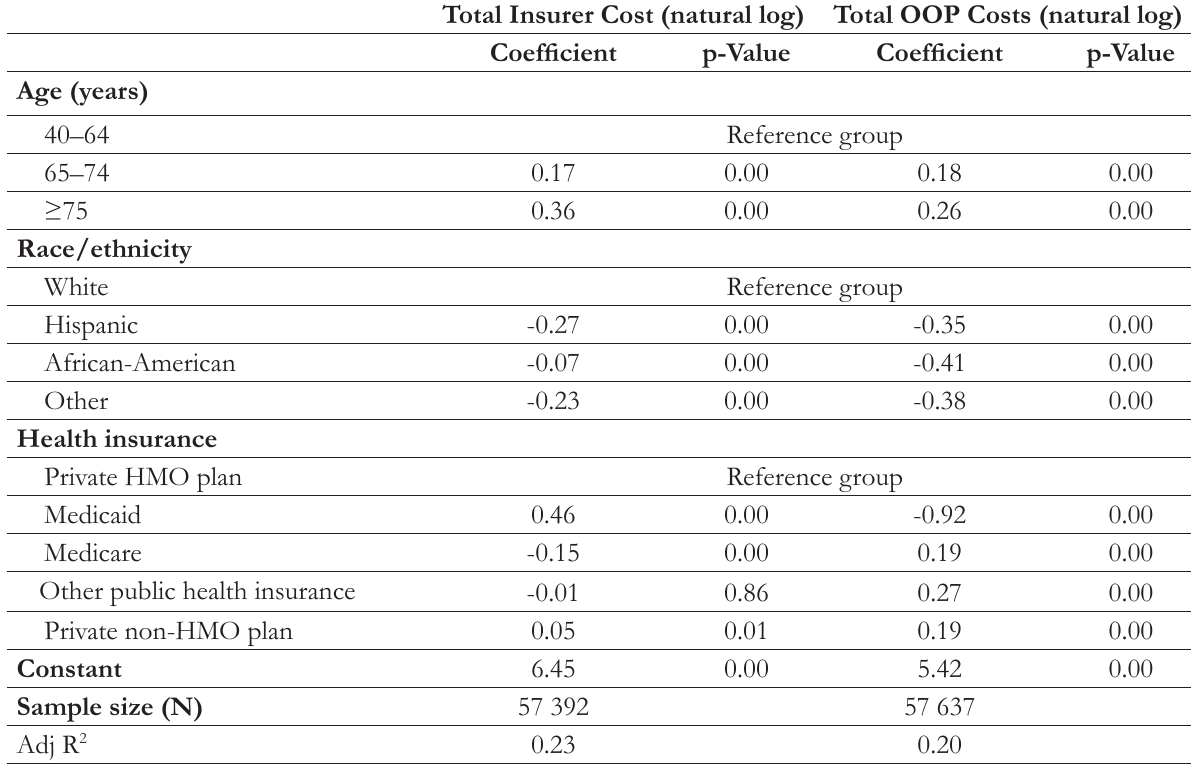
Table 4. Ordinary Least Squares of Total Healthcare Insurer Expenditures and Total OOP Expenditures [per annum] - cont’d